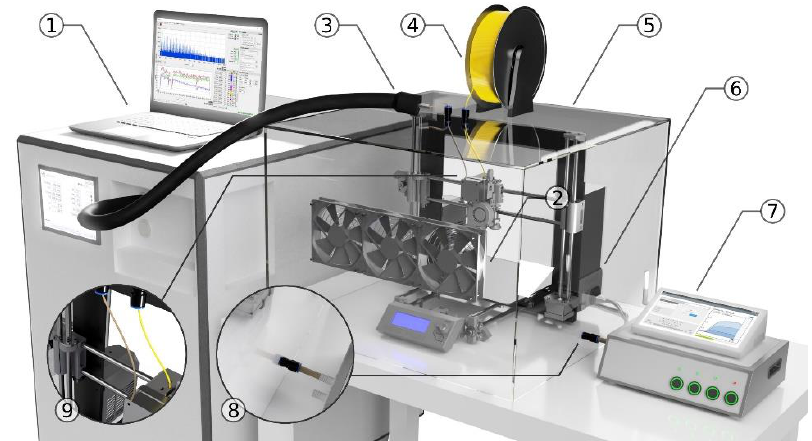
Figure 1. Experimental setup comprised of proton transfer reaction time-of-flight mass spectrometry (PTR-TOFMS) ( 1 ), 120 mm fans ( 2 ), polyether ether ketone (PEEK) capillary housed in a heated transfer line ( 3 ), 1.75 mm acrylonitrile butadiene styrene (ABS) filament ( 4 ), 3D printer enclosure ( 5 ), fused deposition modelling (FDM) 3D printer ( 6 ), and electronic nose ( 7 ), ( 8 ) and ( 9 ) show the positioning of the e-nose and PTR-TOFMS inlet capillaries, respectively.